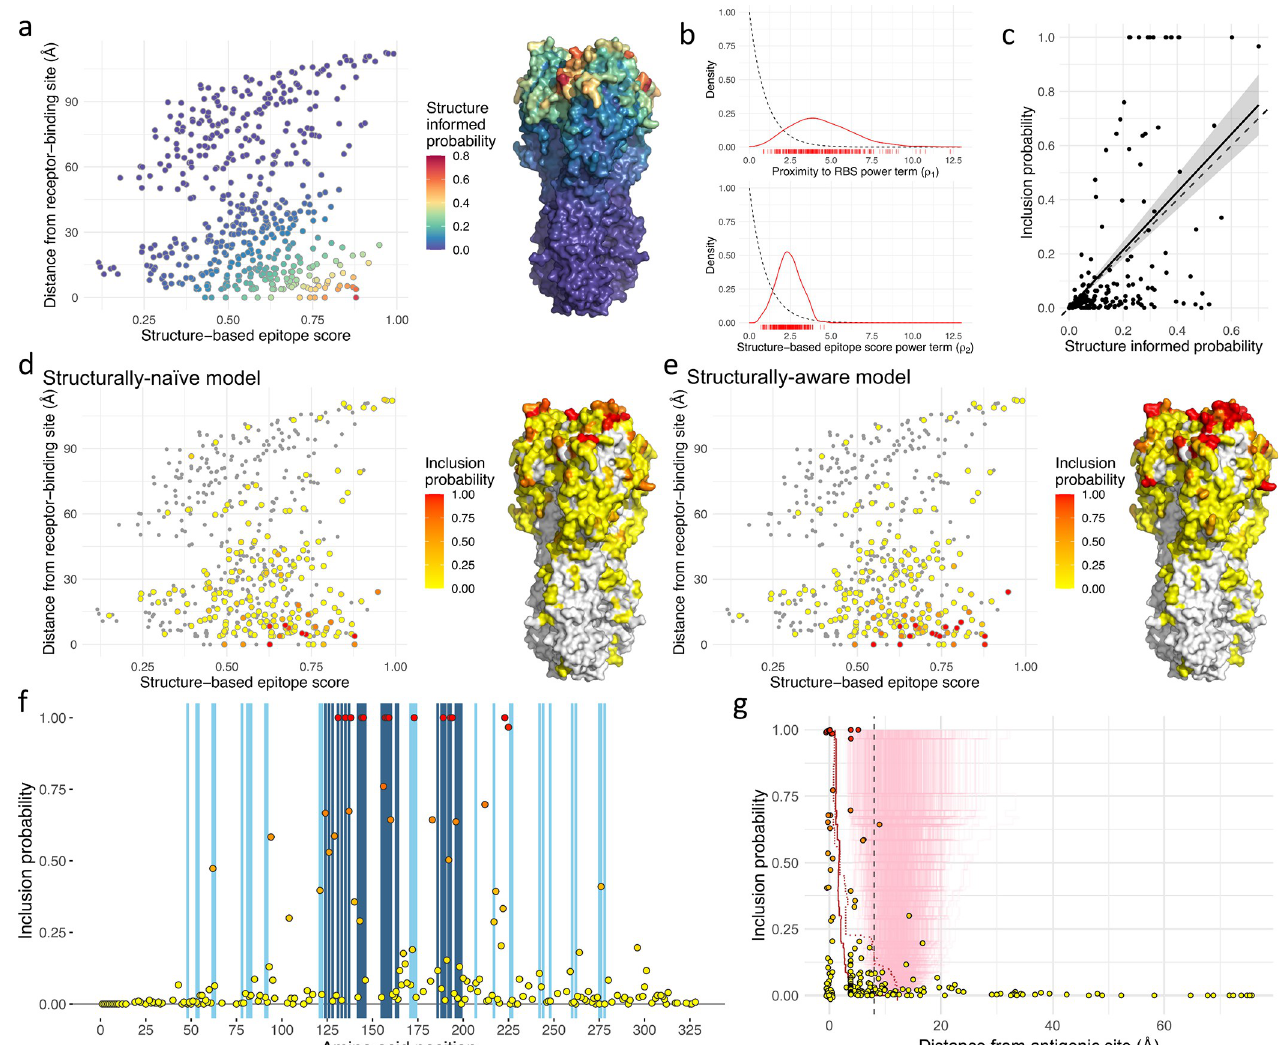
Fig 4. Use of structural data to guide variable selection. Plots summarise variable selection using a model where posterior inclusion probability that substitutions at an HA position affect antigenicity is impacted by a structure-informed probability that depends on a structure-based epitope score and distance from the RBS ( a ). HA residues are positioned according to a structure-based epitope score and distance from the RBS. Colour indicates the structure-informed probability of antigenic importance. To the right, structure informed probability is shown on the HA structure. ( b ) Posterior distributions for power terms that link proximity to the RBS ( ρ 1 , top) and structure-based epitope score ( ρ 2 , bottom) for each HA position to a structure-informed probability for the position, p according to Eq 8. Individual values sampled from the posterior distribution are shown below the x-axis. Prior distributions for these parameters, defined as Gamma(1, 1), are shown as dashed black lines. ( c ) Scatterplot showing the relationship between the structure-informed probability and the posterior inclusion probability. The solid black line has a slope of 1.07 alongside a dashed line of slope 1, with standard error from the linear model indicated in grey. ( d-e ) HA residues are positioned according to structure-based epitope score and distance from the RBS, identical to a . The colour scheme indicates posterior inclusion probabilities estimated using structurally-na ï ve ( d ) and structurally-aware ( e ) models. Positions without substitutions are shown in grey. To the right of each scatterplot, inclusion probabilities are shown on the HA structure. ( f ) Each point represents the posterior inclusion probability for a variable HA1 position. Blue vertical shading indicates positions on the x-axis that are described in antigenic sites A and B (dark blue) and antigenic sites C, D, and E (light blue). ( g ) Inclusion probability for each variable amino acid position is plotted against distance from the closest residue in a described antigenic site. Points at 0 Å on the x-axis representing residues in described antigenic sites, have been adjusted in both dimensions to aid visualisation of overlapping points. A red line indicates the mean distance of residues selected with inclusion probability equal to or higher than that on the y-axis. Light red lines show a null distribution derived from 1,000 randomisations retaining the inclusion probabilities from the model fitted to the data. A dotted red line shows the corresponding line from a structurally- na ï ve model shown in Fig 2c . A dashed vertical line at 8 Å marks a threshold at which a position is approximately two residues away from an amino acid in the described antigenic site.